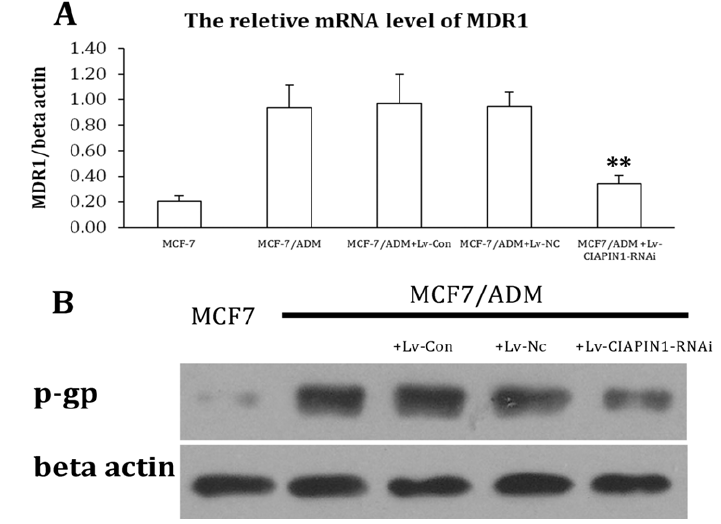
Figure 6. The expression of MDR1mRNA and P-gp in MCF7/ADM cell lines had a statistical significance before and after RNAi ( p ≤ 0.01). These results indicated that